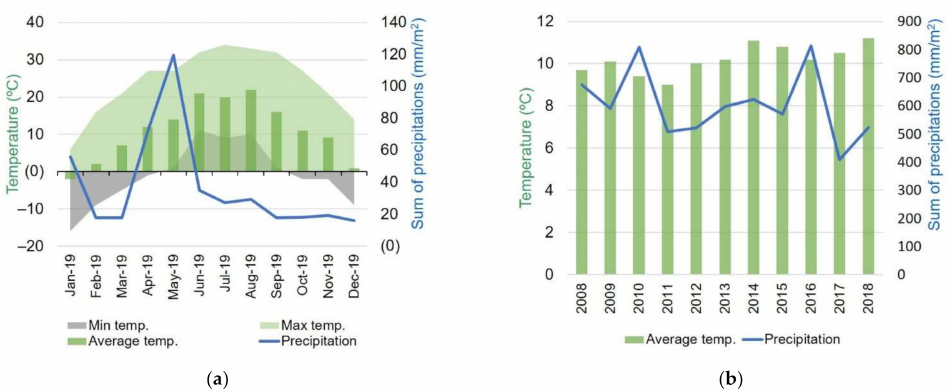
Figure 2. Climatic conditions in Cluj County in ( a ) 2019, and ( b ) previous decade [50,51]. In Agro-Botanical Garden UASVM Cluj-Napoca, the soil has a clay-loam texture with a good humus content and the following macro-nutrient supply: Nitrogen